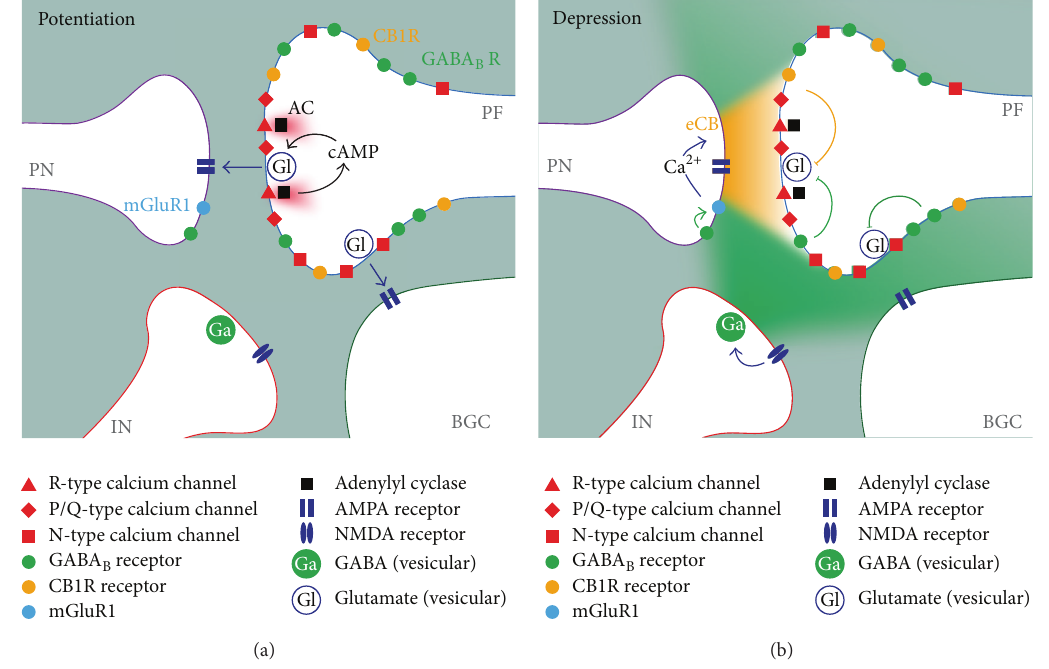
Figure 11: Localization of plasticity mechanisms at the parallel fibre terminal. (a) Illustration of the signalling domains involved in activity- dependent long-term potentiation. Local calcium influx through R-type channels activates adenylyl cyclase, leading to potentiation of vesicle release at the active zone. (b) Illustration of the signalling domains involved in presynaptic depression by CB1 receptors and GABA B receptors. Activation of mGluR1 leads to local release of endocannabinoids in the active zone, possibly enhanced by postsynaptic GABA B R activation. Activation of NMDA receptors leads to widespread tonic GABA increases that engage both synaptic and ectopic release sites. Arrows denote activation mechanisms, bars denote inhibition. PN: Purkinje neuron, PF: parallel fibre, IN: interneuron, and BGC: Bergmann glial cell. Synaptic sites in active zone activate PN AMPA receptors, and ectopic sites in terminal periphery activate BGC AMPA